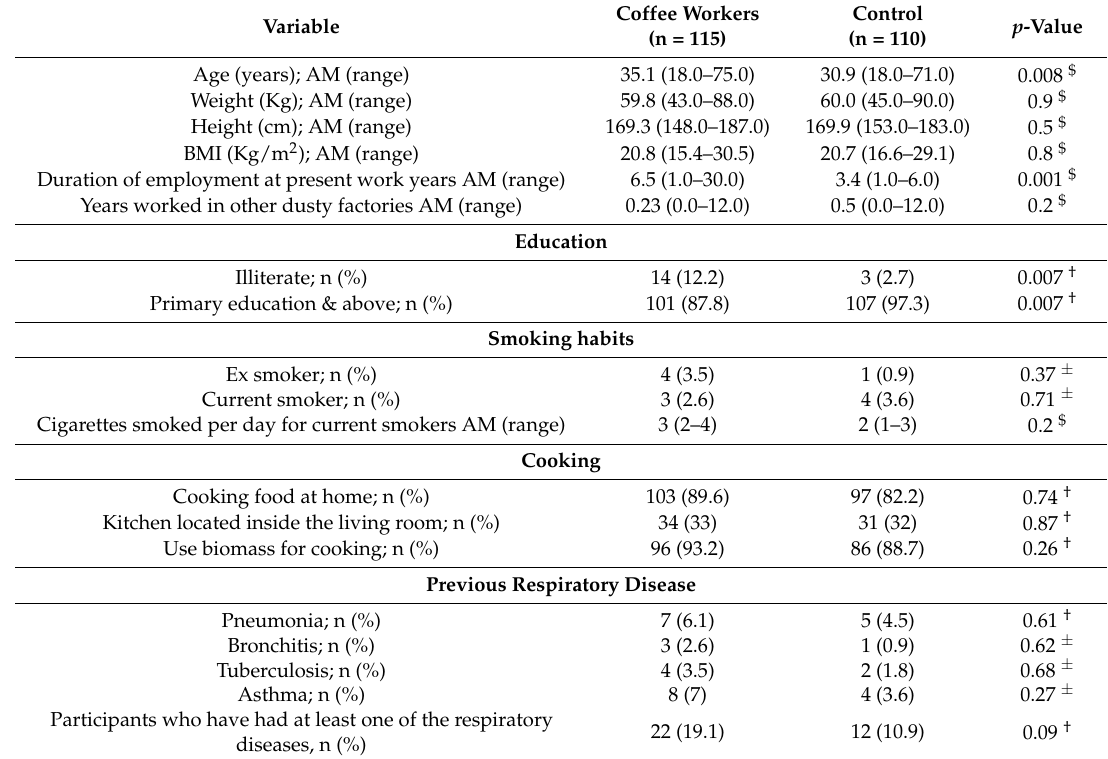
Table 1. Characteristics of the